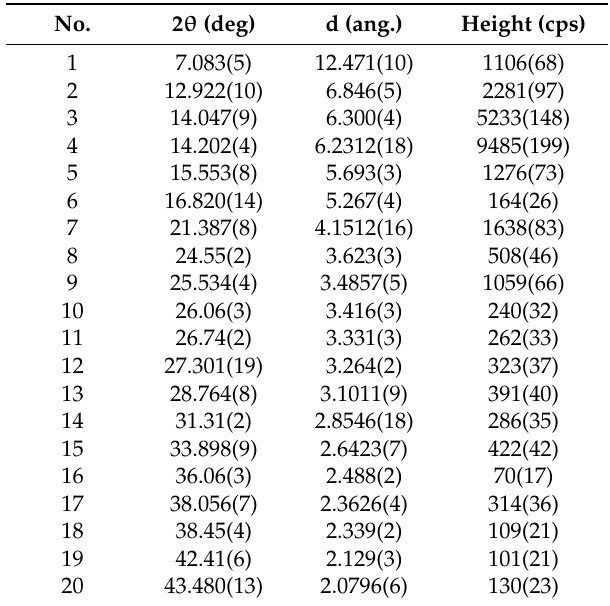
Table 1. X-ray powder pattern of compound 3c .